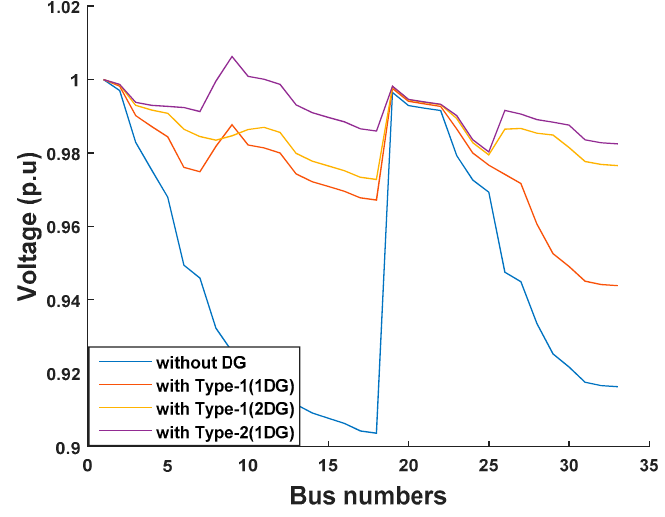
Figure 16. Voltage profile for Type-1 (1 DG and 2 DG) and Type-3 (1 DG).